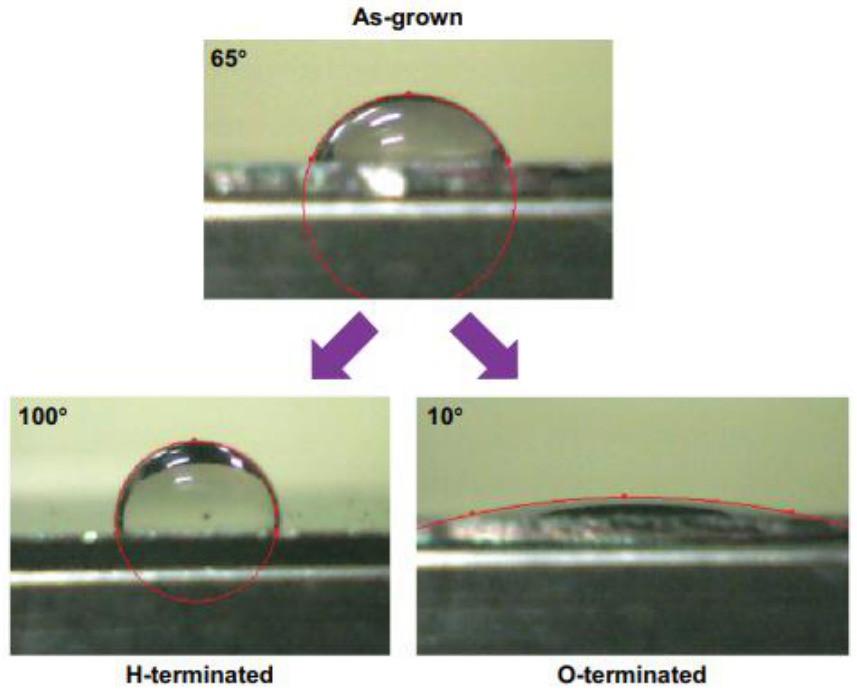
Figure 5. Wetting properties of diamond films as grown and treated in hydrogen plasma (H-terminated) or oxygen plasma (O-terminated) (From Ref. [105]).